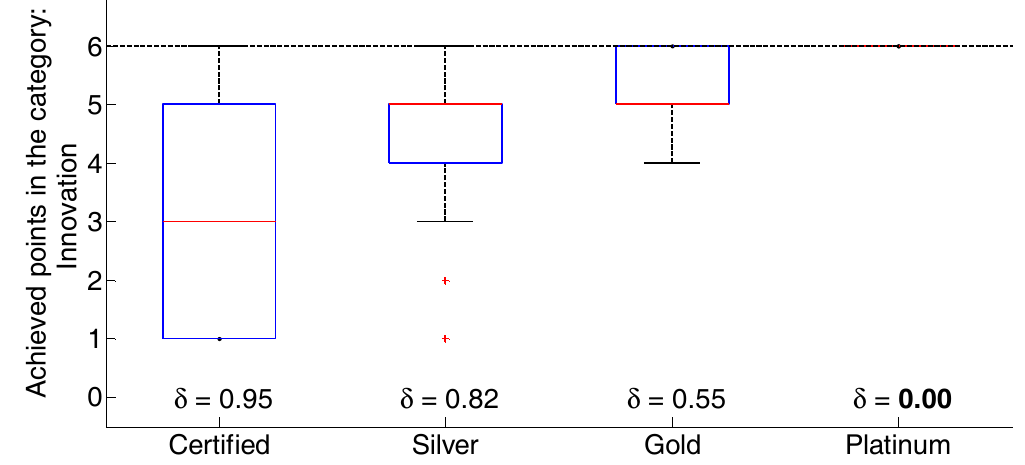
Figure 8. Boxplot results and Cliff’s δ effect size between possible and achieved points in the Innovation (IN) category. Effect size is considered to be: very high if | δ | < 0.147 (bold font), high if 0.147 < | δ | < 0.33 (bold italic font), medium if 0.33 < | δ | < 0.474 (italic font), and low if | δ | ≥ 0.474 (normal font).